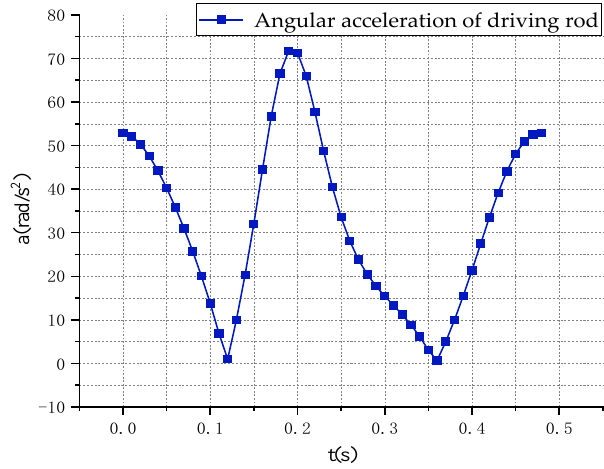
Figure 5. Angular acceleration of drive rod.